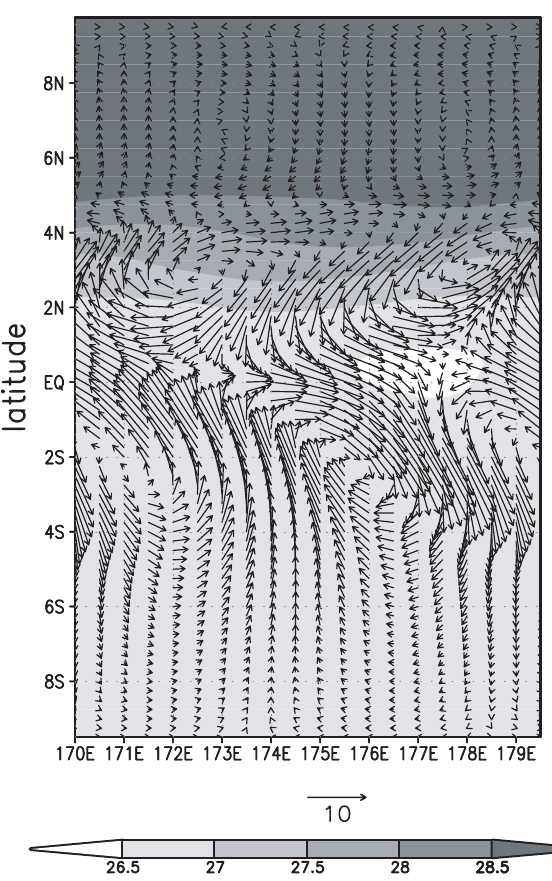
Fig. 8. Horizontal snapshot of temperature (shaded) and perturba- tion velocity vectors at 5m after 110 days of integration of EXP 9. Contour interval is 0.5 ◦ C for temperature and the unit vector is 10cm/s.